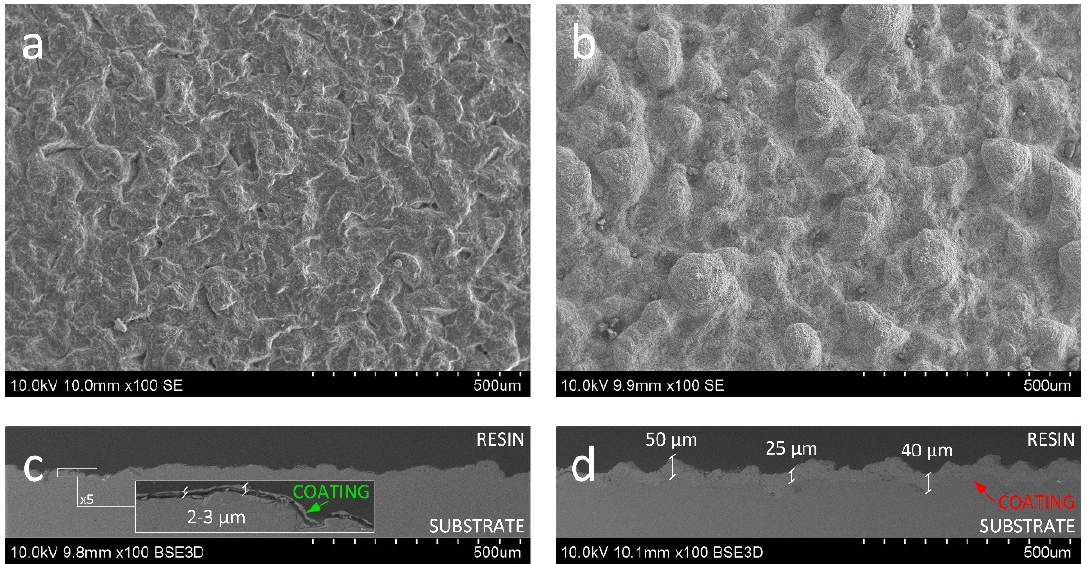
Figure 3. SEM micrograph of ( a , b ) topography and ( c , d ) cross section of ( a , c ) 200 and ( b , d ) 600 coatings. General view.